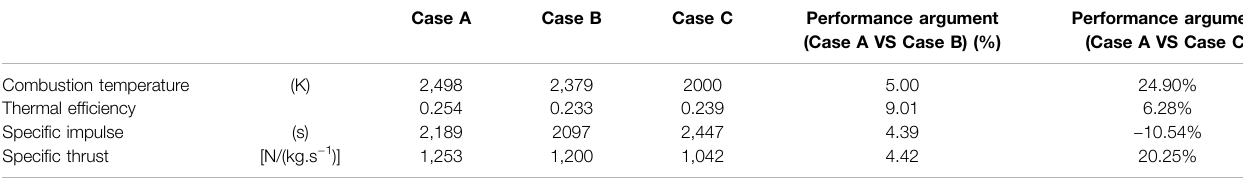
TABLE 5 | Performance comparison among the three thermal systems of engines.